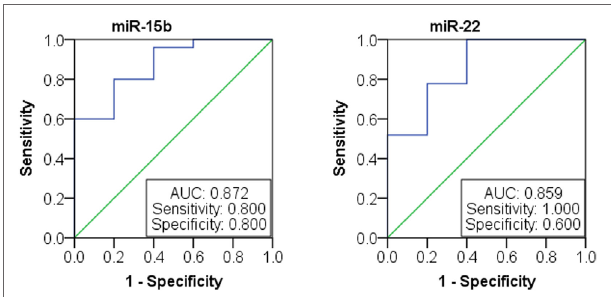
FigUre 6 | Receiver operating characteristic curve analysis of miR-15b and miR-22 microRNAs (miRNAs) expression in patients with lupus